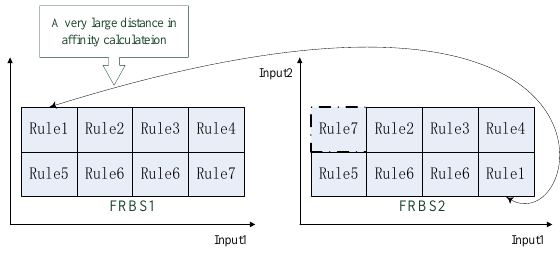
Fig. 4. The problems associated with the FRBS having different rule lengths and unconstrained